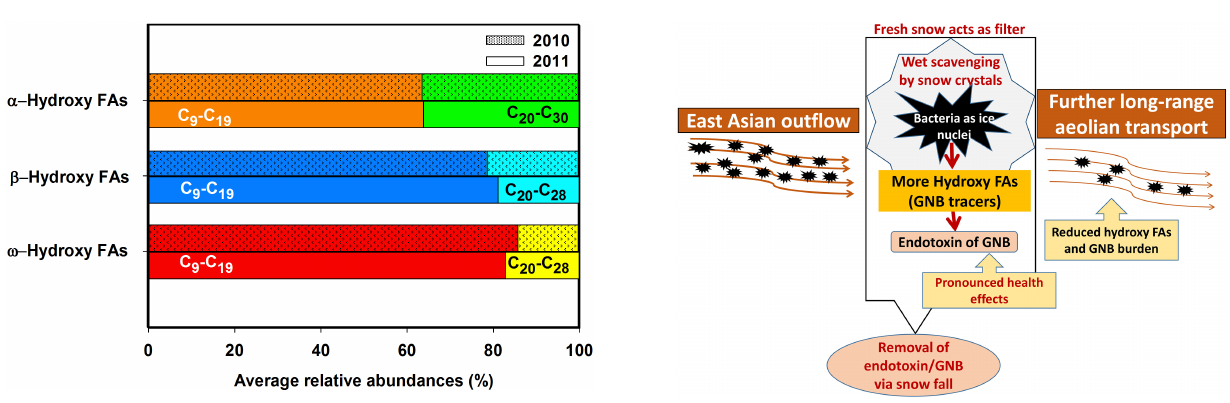
Figure 4. Conceptual model to explain the scavenging of hydroxy fatty acids (FAs) by fresh snow in the free troposphere. Snowfall in northern Japan acts as a filter in reducing the hydroxy FAs (tracers of Gram-negative bacteria; GNB), which in turn results in the re- moval of endotoxins from the atmosphere and a reduction in their health effects during long-range aeolian dust